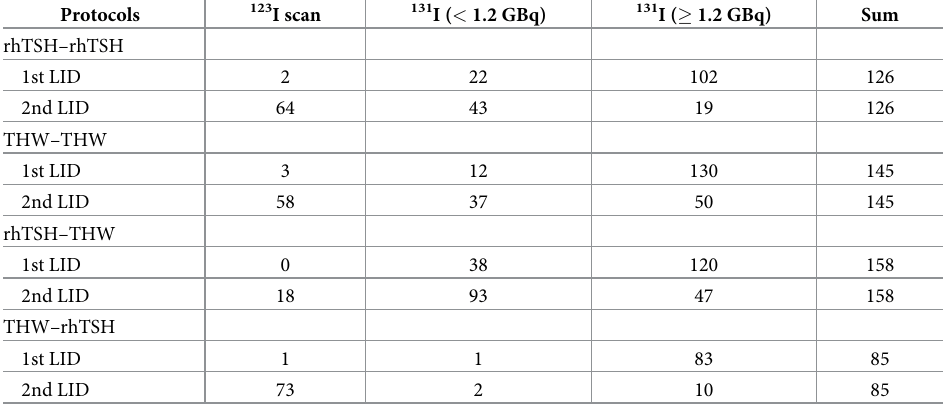
Table 3. The number of patients according to TSH stimulation protocols and LID procedures in those who under- went the first and second LID during the study period. Protocols 123 I scan 131 I ( < 1.2